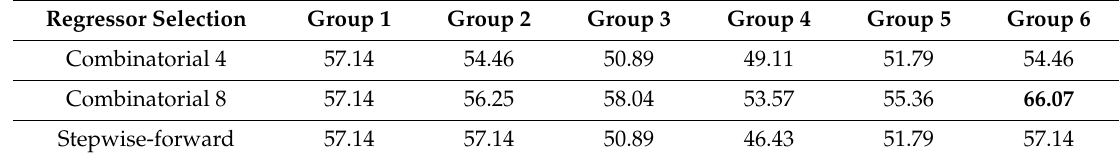
Table 5. Bank Rating forecasting accuracy by the probit model (%).